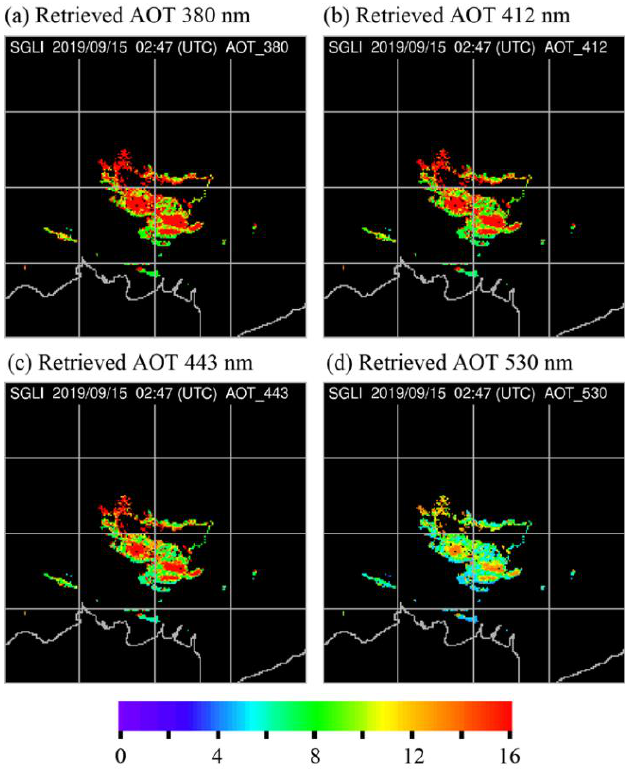
Figure 8. Distribution of aerosol optical thickness (AOT) at ( a ) 380 nm, ( b ) 412 nm, ( c ) 443 nm, and ( d ) 530